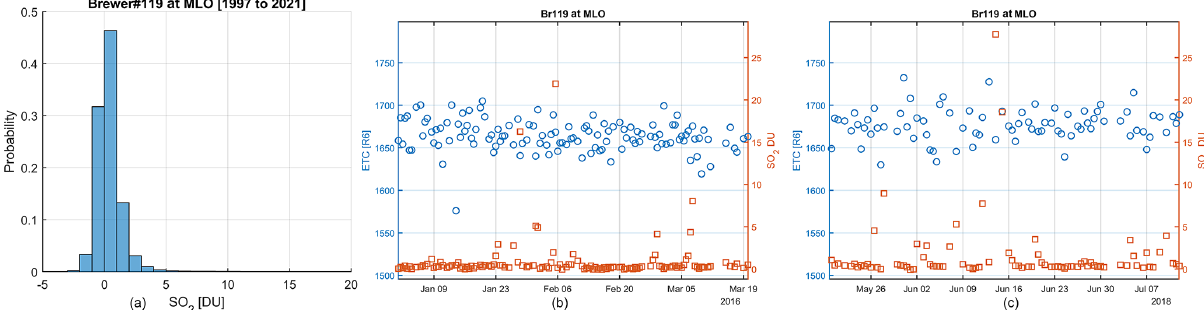
Figure B2. Histogram (a) of column SO 2 measured by Brewer #119 at MLO. Example time series (b and c) of fitted ETCs and observed SO 2